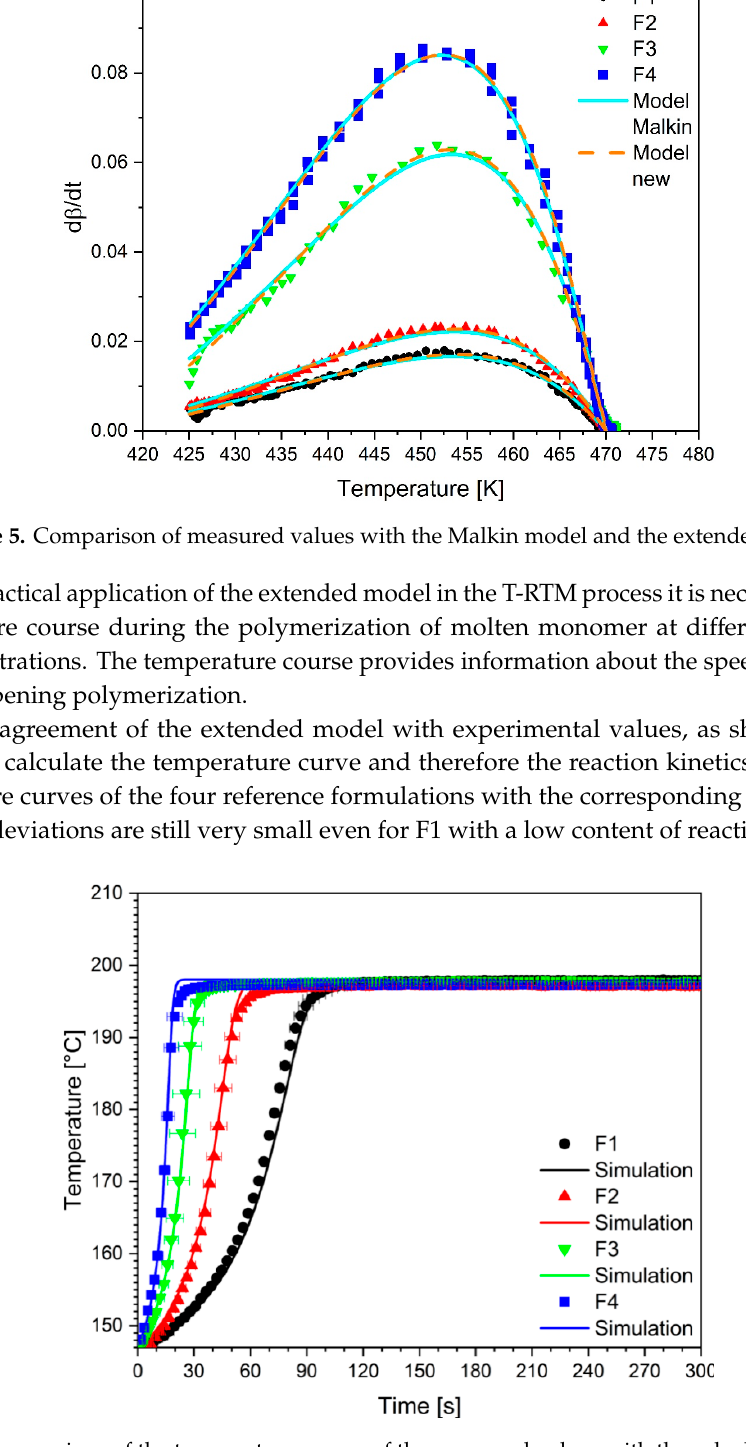
Figure 6. Comparison of the temperature curves of the measured values with the calculated values of the model.